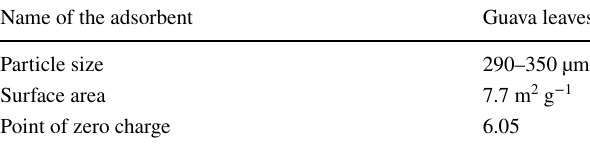
Table 1 Characteristics of guava leaves